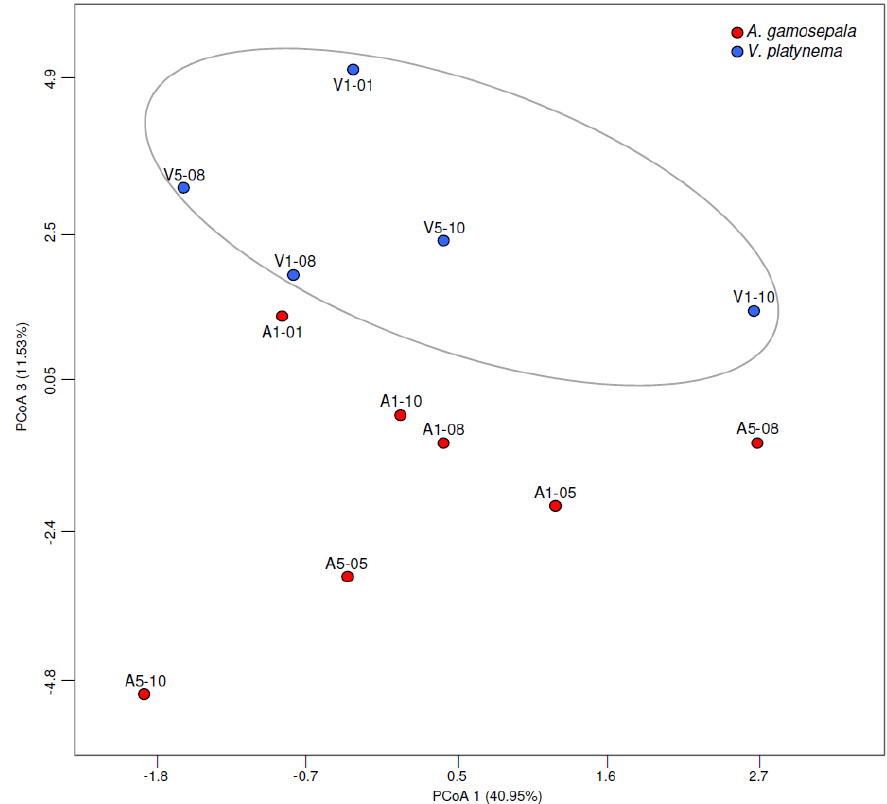
Figure 7. Two-dimensional projection of the DNA metabarcoding analysis using principal coordinate analysis (PCoA) based on a Bray–Curtis distance matrix ( A ). The axes represent two of the synthetic variables (PCo1 and PCo3), with the percentage of the total variance explained by each of them in parentheses. Each point represents the microbial community from one specimen, colored according to the bromeliad species: red dots indicate A. gamosepala ( A1 and A5 ) and blue dots indicate V. platynema ( V1 and V5 , delimited by ellipse), in a specific season (01 - Summer; 05 - Fall; 08 - Winter; 10 - Spring).